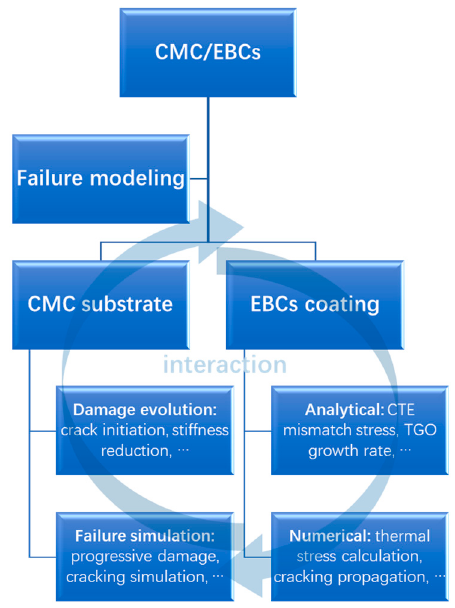
Figure 10. The failure modeling methodology of the CMC/EBC system.